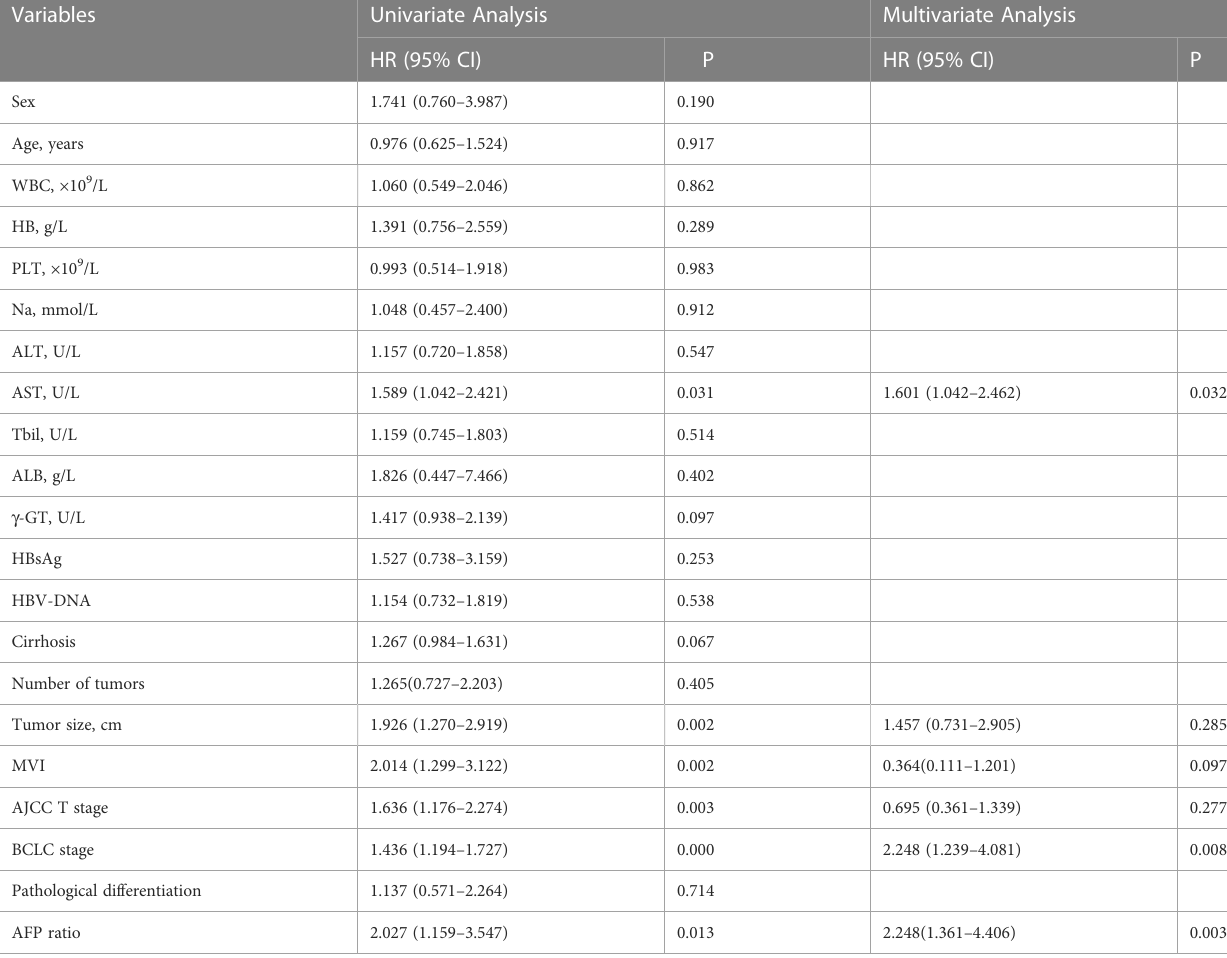
TABLE 4 Univariate and multivariate analyses for recurrence free survival in the validation